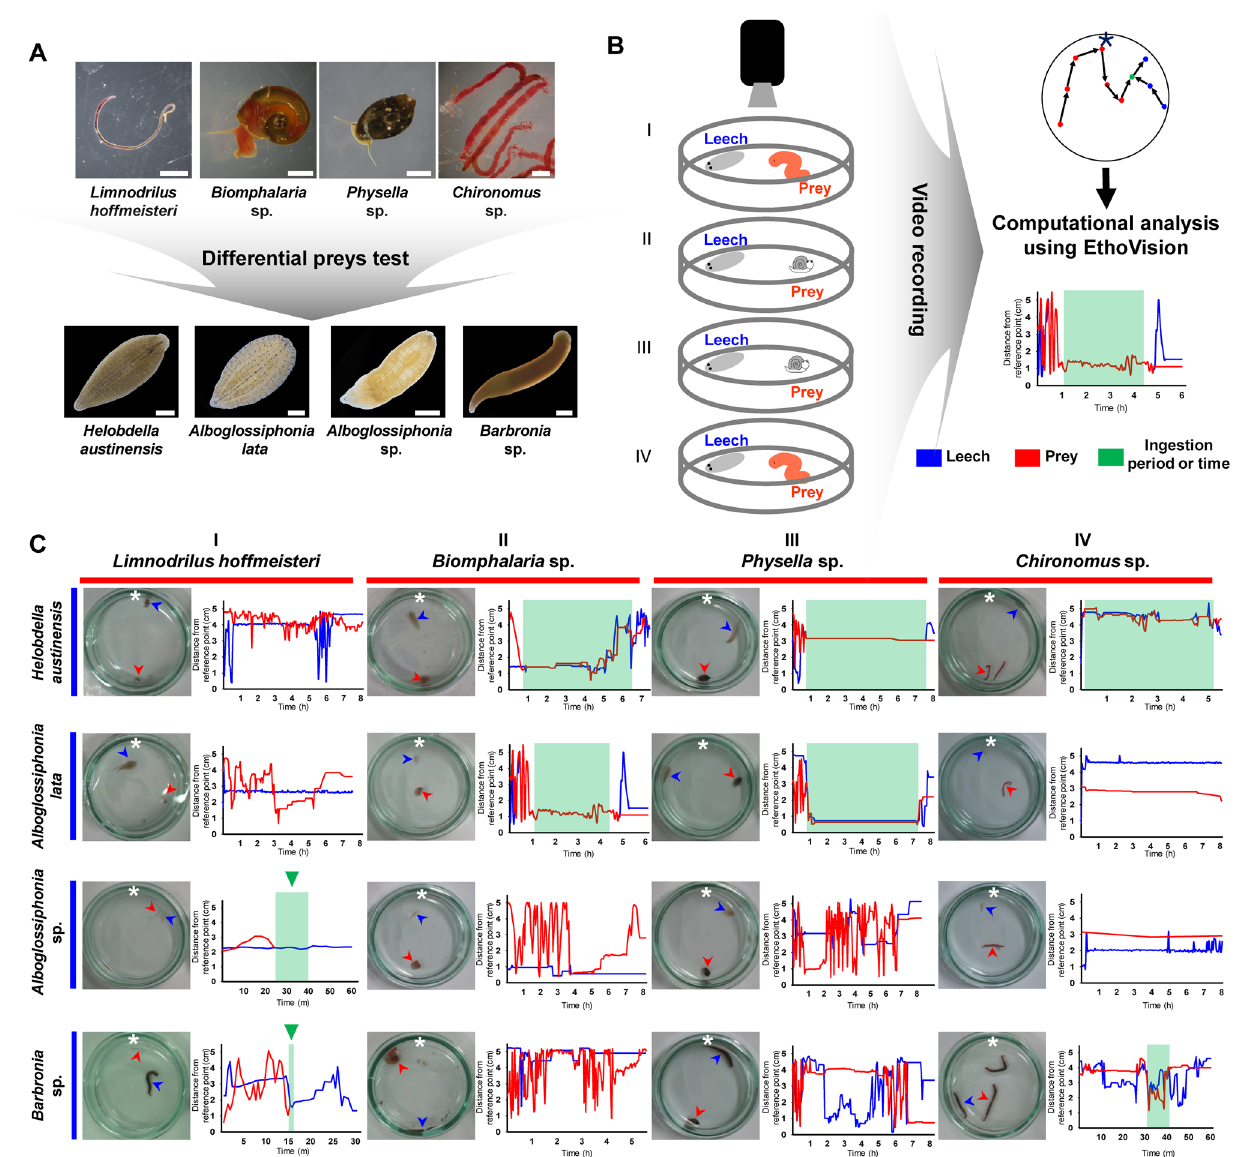
Figure 2. Comparative ingestion behavior of leeches with different food sources. ( A ) Representative leech species and prey types. See also Supplementary Movies 1–4 for detailed ingestion behavior. Scale bars 2 mm. ( B ) Schematic procedure of different ingestion tests depending on prey type. The recorded locomotion of a leech and its prey was analyzed using EthoVision, a target tracking program. The relative distance from leech (shown in blue) or prey (shown in red) to the reference point (asterisk) was measured. Ingestion period is indicated by green box. ( C ) Representative behaviors of leeches in the presence of specific prey. Each graph represents the distance between the leech (blue arrowhead) and the food (red arrowhead) from the reference point (white asterisk). When a fluid sucking leech adhered to food, its position was consistent (green box) for a period of time. After ingestion of food, the remaining prey that cannot be swallowed persisted. In the case of macrophagous leeches, only locations of the leech remained detectable (green box with green arrowhead) after ingestion of whole prey targets by the leech. Only Limnodrilus hoffmeisteri was fully ingestible by